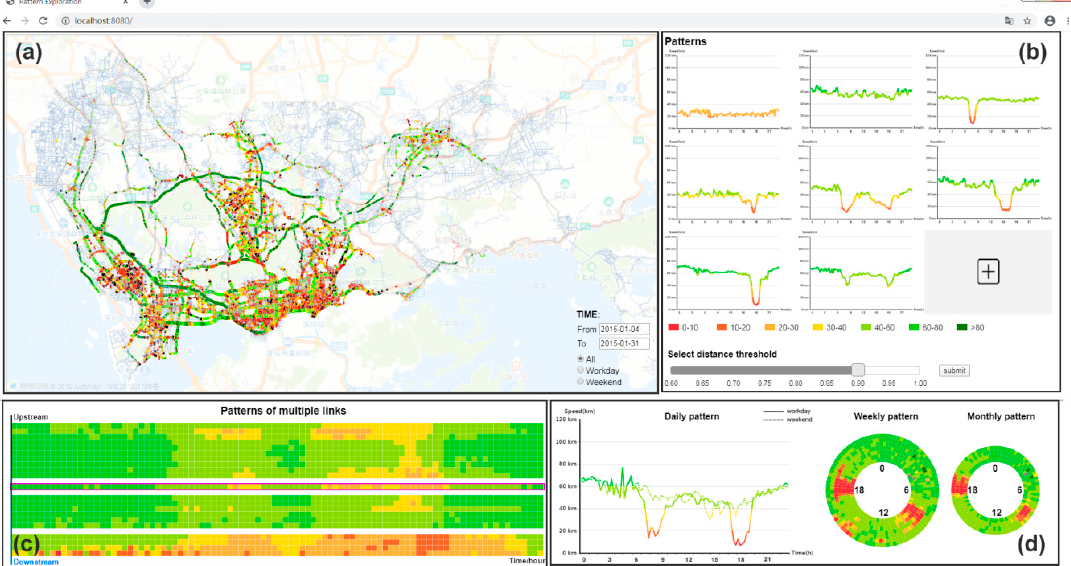
Figure 2. Interactive interface for exploring urban traffic pattern. ( a ) A map view that shows road links with the traffic state. ( b ) A pattern view for querying road links with similar traffic dynamics with a specified traffic pattern. By default, it gives the most typical road traffic patterns. ( c ) A spatial view that shows the traffic patterns of a selected road (with black frame in the middle) and its adjacent road links. ( d ) Temporal views that display the daily, weekly, and monthly traffic patterns in both a linear and radial diagram.